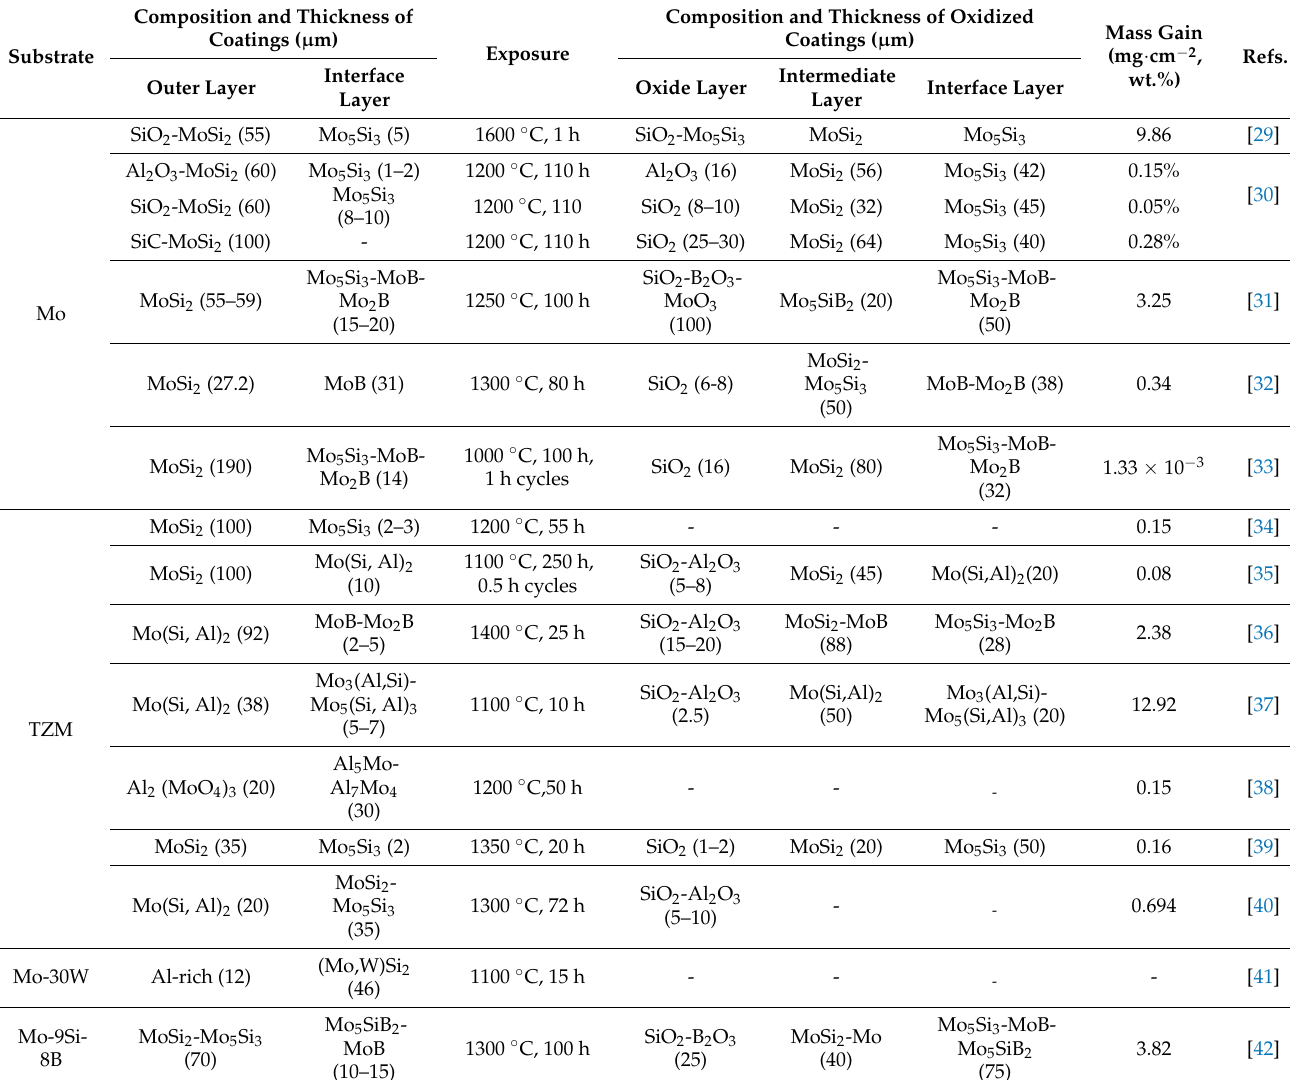
Table 3. Oxidation process parameters and oxidation properties of HAPC coatings on molybdenum and its alloys. Composition and Thickness of Composition and Thickness of Oxidized Coatings ( µ m) Coatings ( µ m) Exposure Substrate